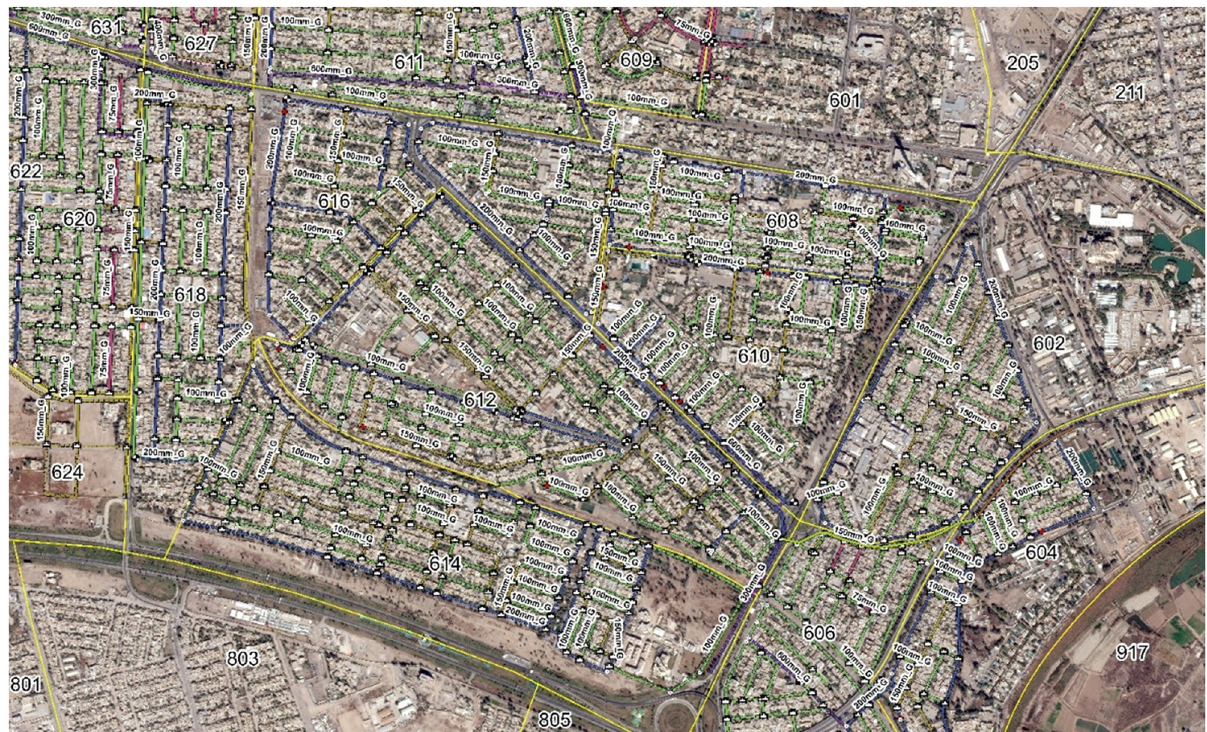
Figure 2: The layout of the